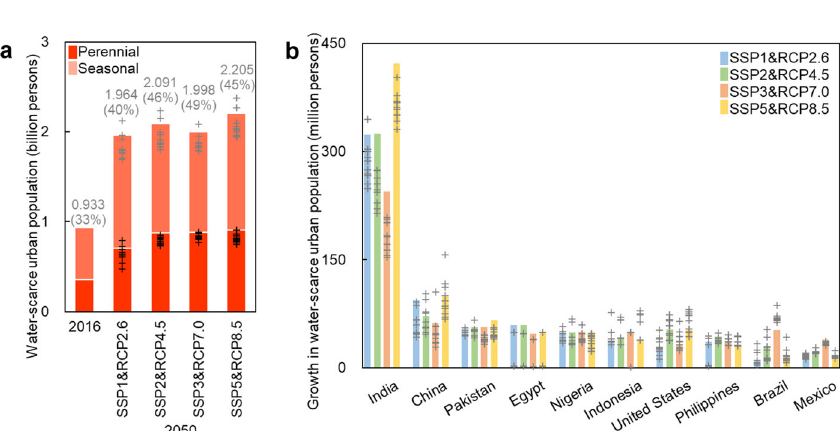
Fig. 2 Changes in urban water scarcity from 2016 to 2050. a Changes in water-scarce urban population at the global scale. Bars present the simulated results using the ensemble mean of runoff from GCMs, the total values (i.e., perennial and seasonal), and percentages are labeled. Crosses (gray/black) present the simulated results (total/perennial) using runoff from each GCM. b Changes in water-scarce urban population at the national scale (10 countries with the largest values were listed). Bars present the total values simulated using the ensemble mean of runoff from GCMs. Crosses present the total values simulated using runoff from each GCM. Please refer to Supplementary Data for urban water scarcity in each